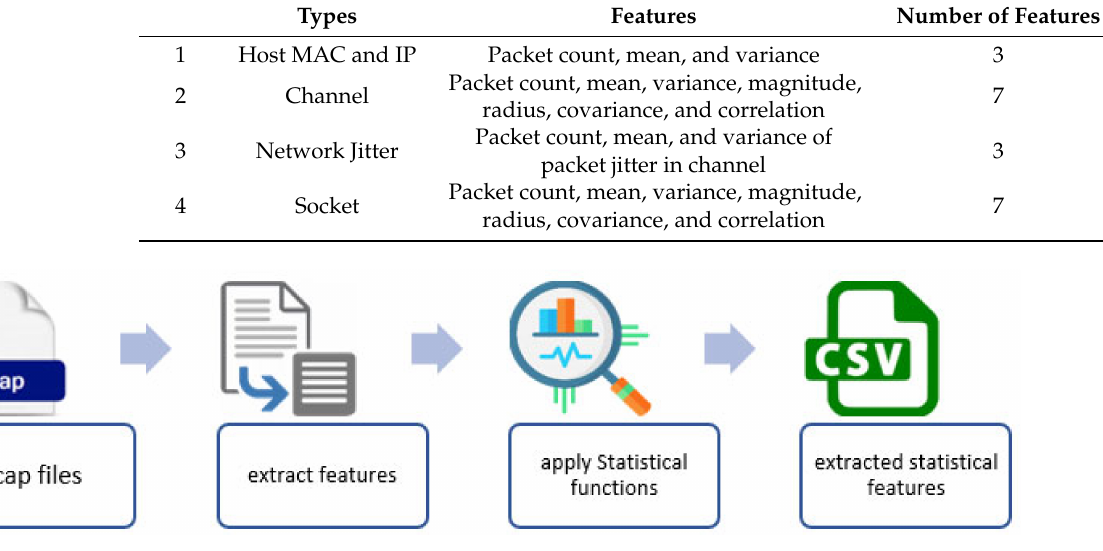
Figure 9. Feature selection and